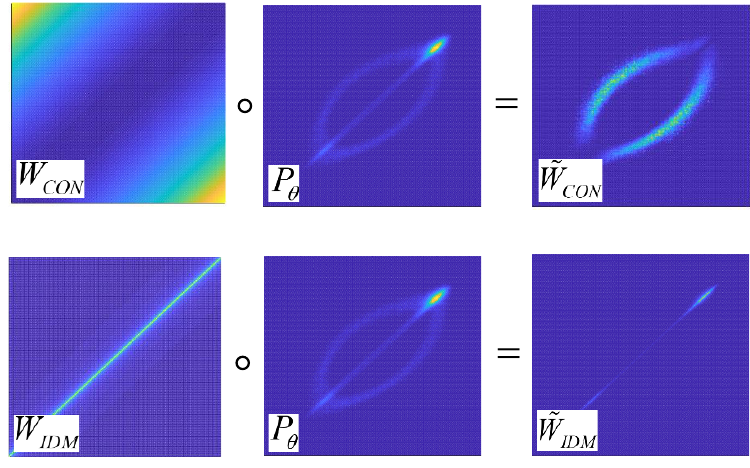
Figure 2. Illustration of visualization about enhancement of CON and IDM